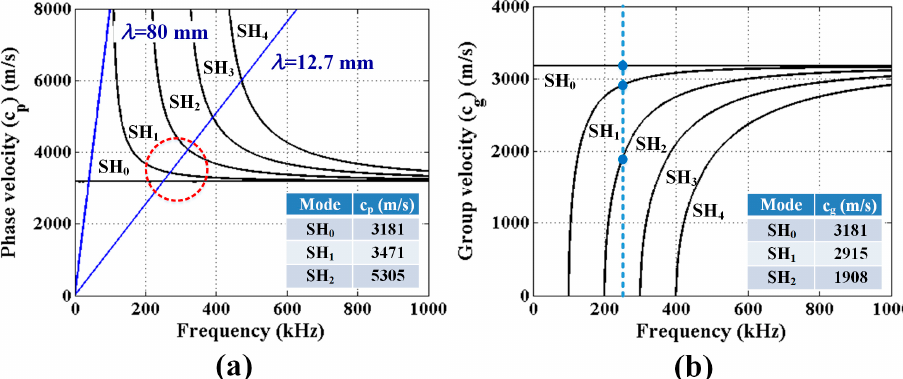
Figure 4. ( a ) Phase; and ( b ) group velocity dispersion curves for SH modes of a 15.9 thick stainless steel plate.